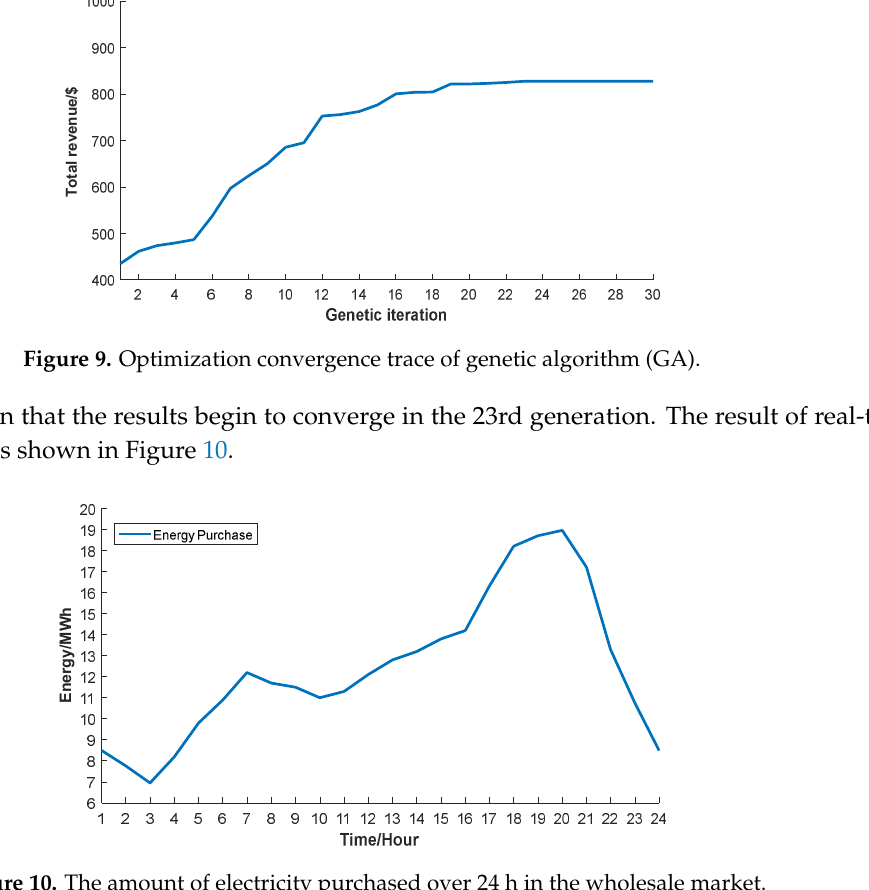
Figure 11 . The electricity retail price for 24 h. After the implementation at the fog/cloud layers, the DSO can create a purchasing strategy from the wholesale market. The wholesale market price is set as 0.353 cents/kWh. Finally, the cost and revenue of each stakeholder in a day (24 h) are listed in Table 2 Table 2. Analysis of revenue of entities in a day. Cost of normal customers ($)